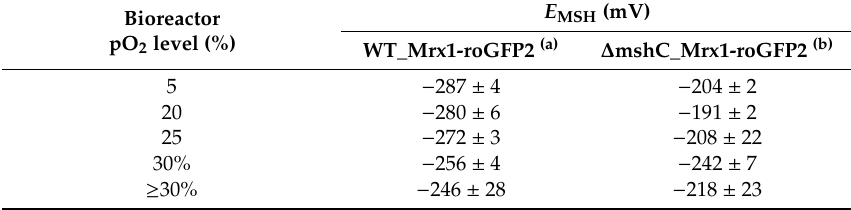
Table 2. Mycothiol redox potential ( E MSH ; Nernst equation) during bioreactor